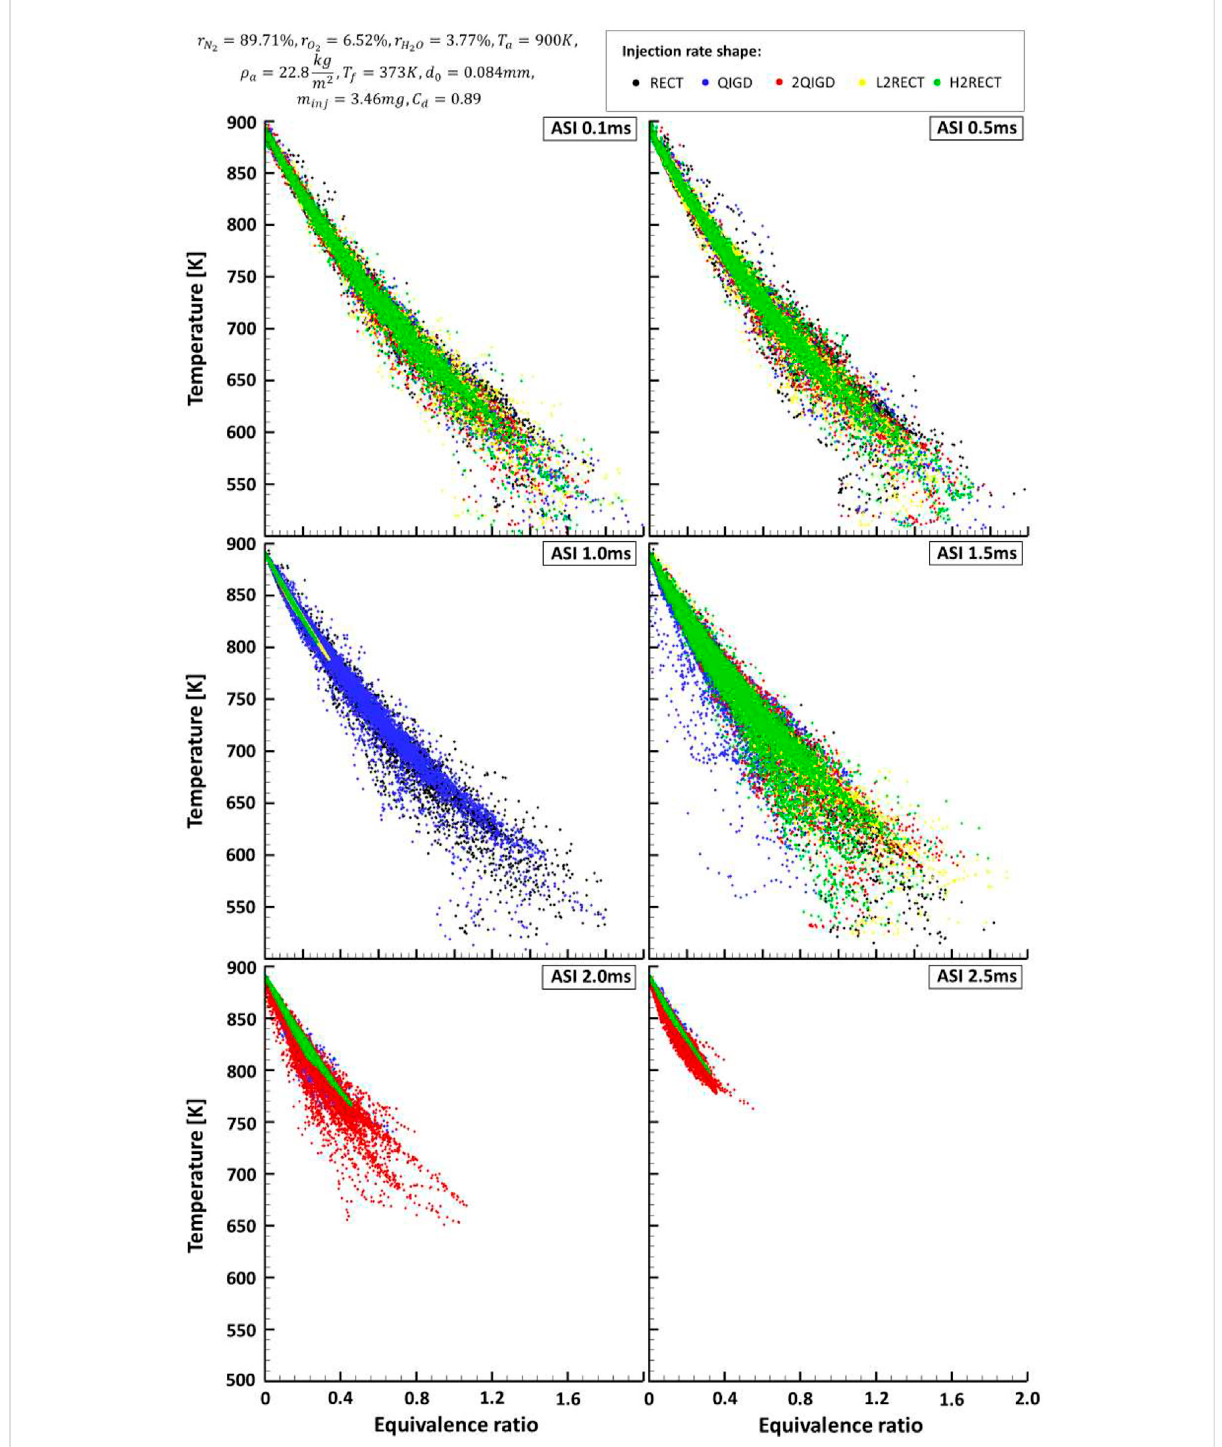
FIGURE 20 Spray temporal evolution in the resolution of equivalence ratio and temperature for different injection